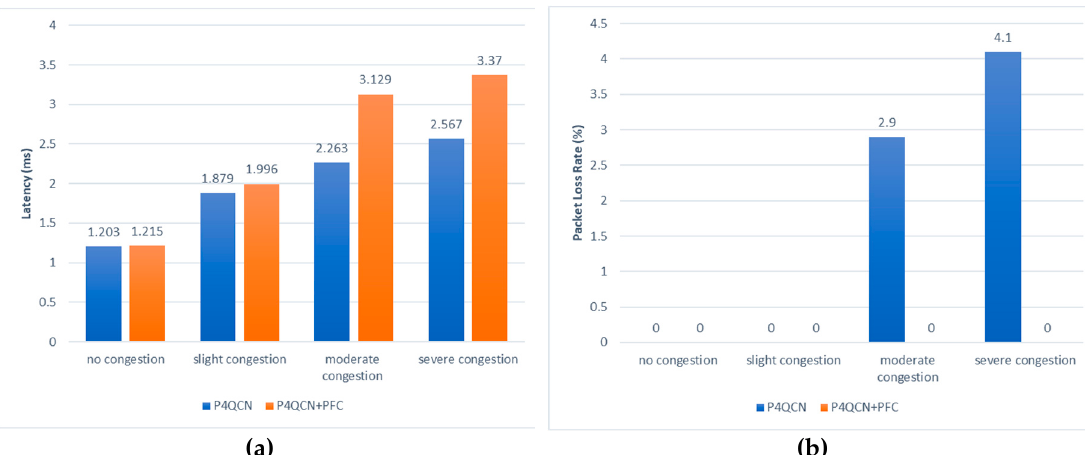
Figure 14. ( a ) Latency comparison of P4QCN and P4QCN + PFC; ( b ) Packet loss comparison of P4QCN and P4QCN + PFC.